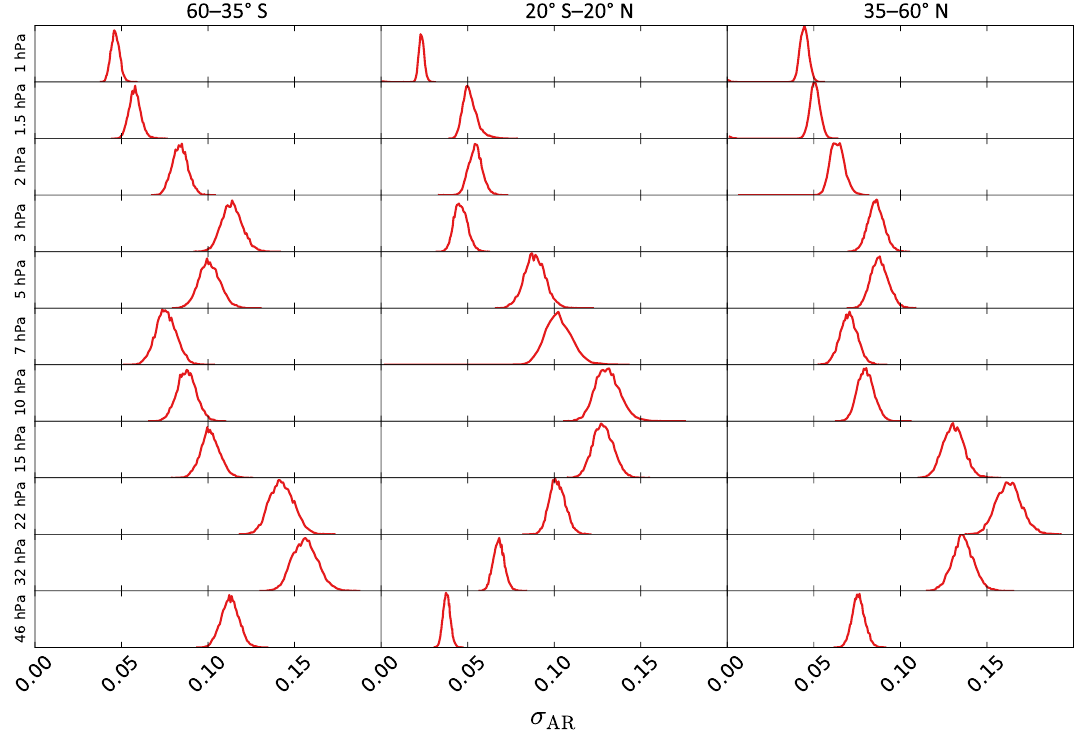
Figure A6. Recovered posteriors on σ AR from the DLM analysis performed in Sect. 5.